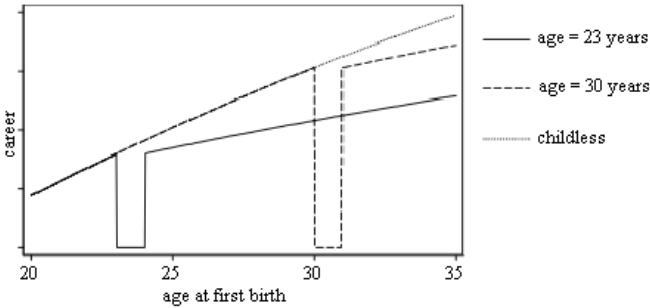
Note: figure abstracted and adjusted from Miller